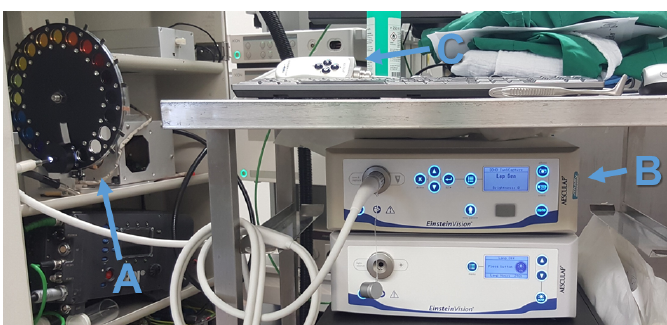
Figure 2. Stereo-spectral system setup: (A) the Xe light source with the filter-wheel, (B) the capturing unit, and (C) the endoscopic